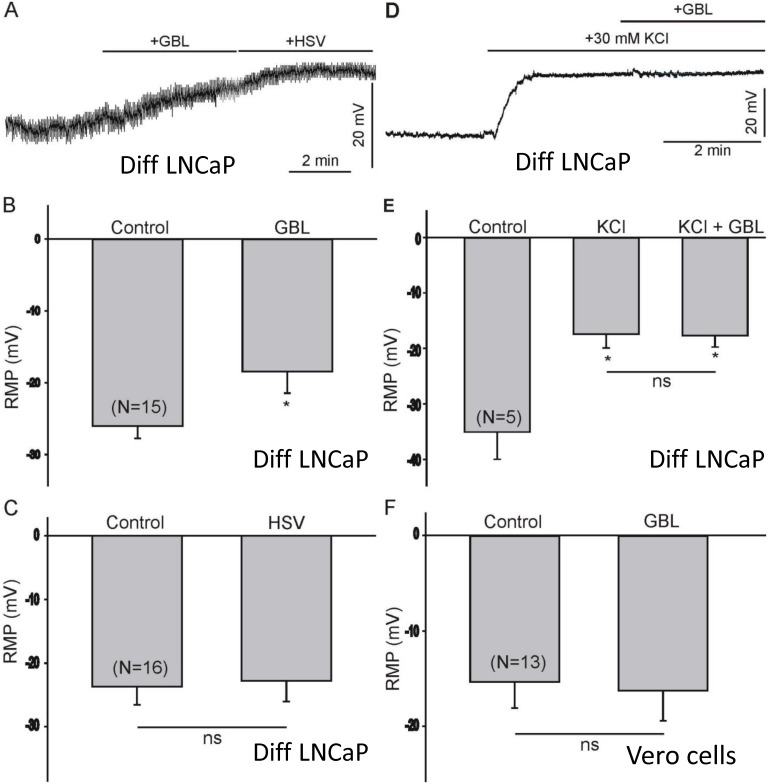
GBL altered RMP of differentiated LNCaP.A. Stimulation of differentiated LNCaP cells with 40 mM GBL caused a significant depolarization of the RMP. B. Treatment with 40 mM GBL for 2–3 min resulted in a significant depolarization of the RMP (p≤0.05 using single tail, unequal variance, unpaired student's t-test). In this and subsequent bar figures, N represents the number of recorded cells in each test group. C. Stimulation of differentiated LNCaP cells with HSV-1 did not result in any change in RMP by Student’s t-test (NS denotes No significance, p>0.05). D. Stimulation of differentiated LNCaP cells with 30 mM extracellular KCl resulted in a significant depolarization of the RMP. Exposure to GBL did not generate any further change in the RMP following membrane depolarization with 30 mM KCl. E. Summary of the changes in the RMP evoked by 30 mM KCl and GBL treatment in differentiated LNCaP cells. Bars labeled with an asterisk (*) were shown to be statistically different compared to controls with a p≤0.05 using an ANOVA multiple comparison test. NS indicates Not Significant. F. Stimulation of Vero cells with GBL (40 mM) has no significant effect on the RMP. Statistical study was calculated by the Student’s t-tests.